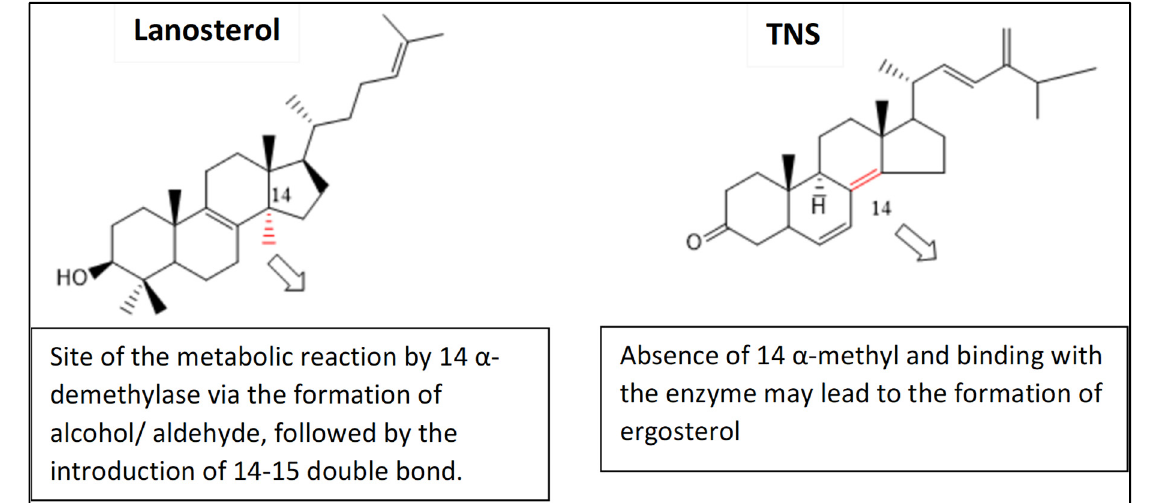
Figure 11. The proposed effect of the structural difference between TNS and lanosterol on ergos- terol biosynthesis.